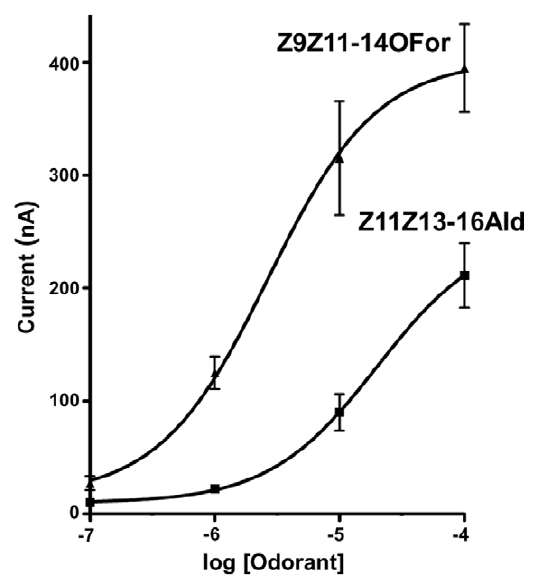
Figure 5. Dose-dependent current responses obtained with AtraOR1 N AtraOrco-expressing oocytes. Note the curve generated by challenging the oocytes with the formate analog is shifted at least one order of